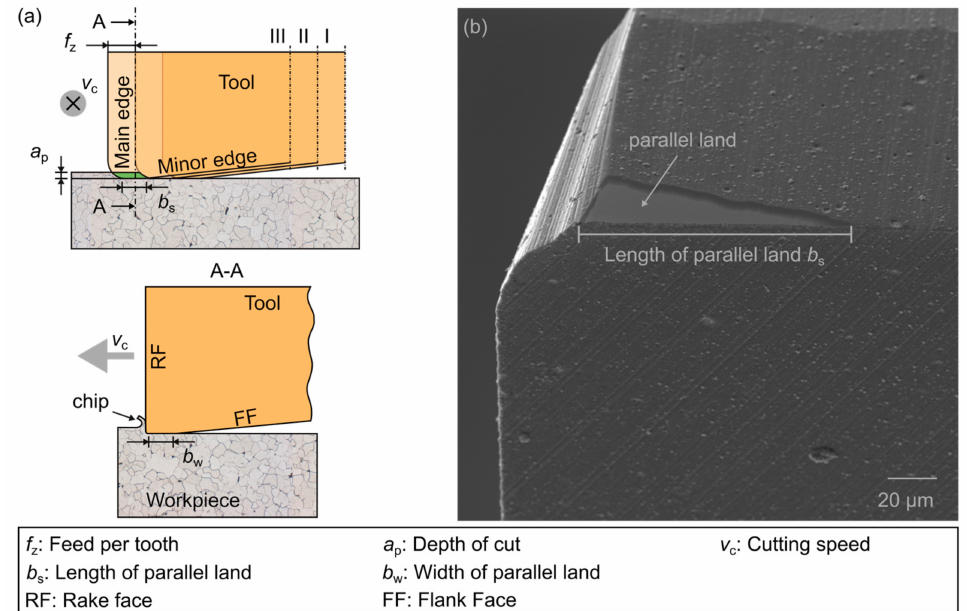
Figure 2. Modified engagement situation of tools with wiper geometry ( a )—according to [24]; ( b ) preparation result of a tool in the focus of this